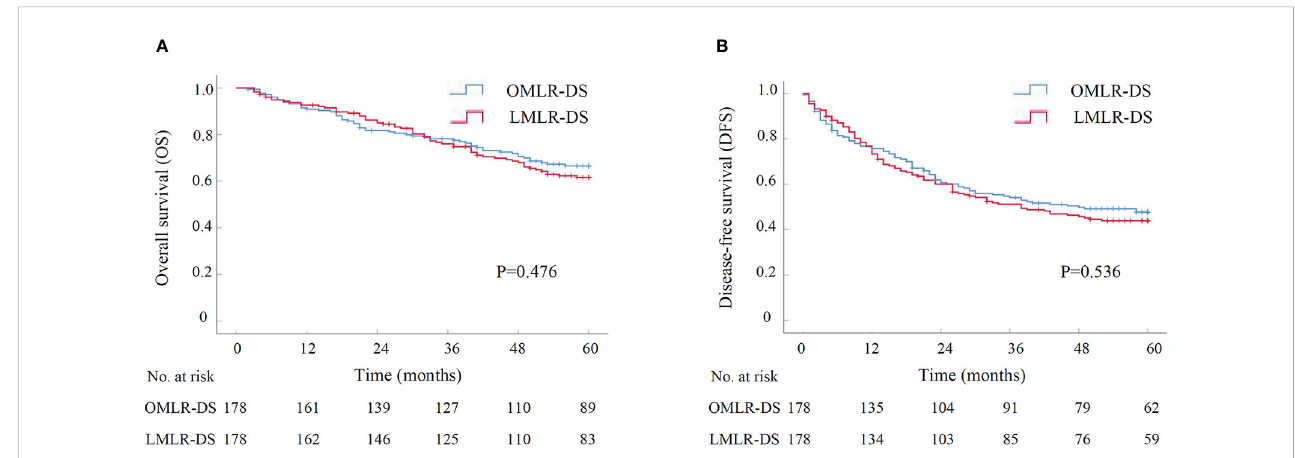
FIGURE 2 The survival curve of LMLR-DS versus OMLR-DS for HCCs after PSM by Kaplan-Meier analysis (N=178 for each group). (A) Overall survival; (B) Disease- free survival. LMLR-DS, laparoscopic minor liver resection in dif fi cult segments (1, 4a, 7 and 8); OMLR-DS, open minor liver resection in dif fi cult segments; PSM, propensity score